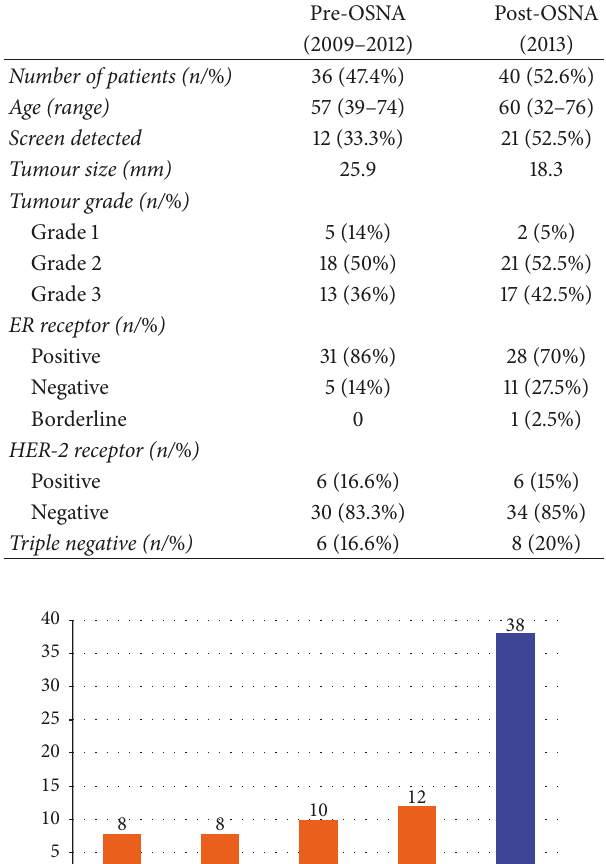
Table 1: Demographic and tumour characteristics.